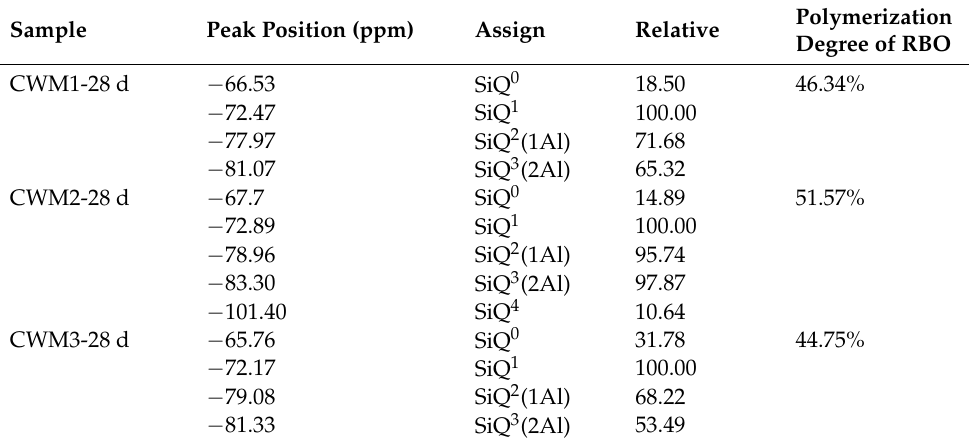
Table 4. NMR data of